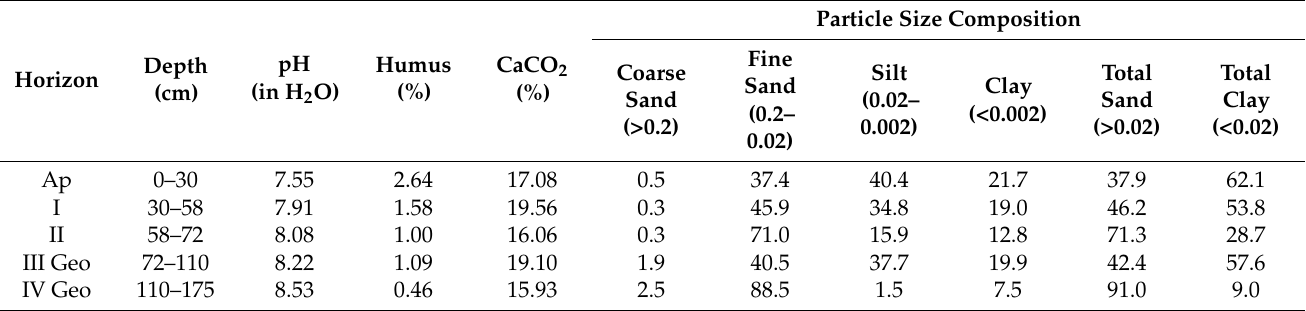
Table 2. Chemical properties and particle size composition of the soil used in the